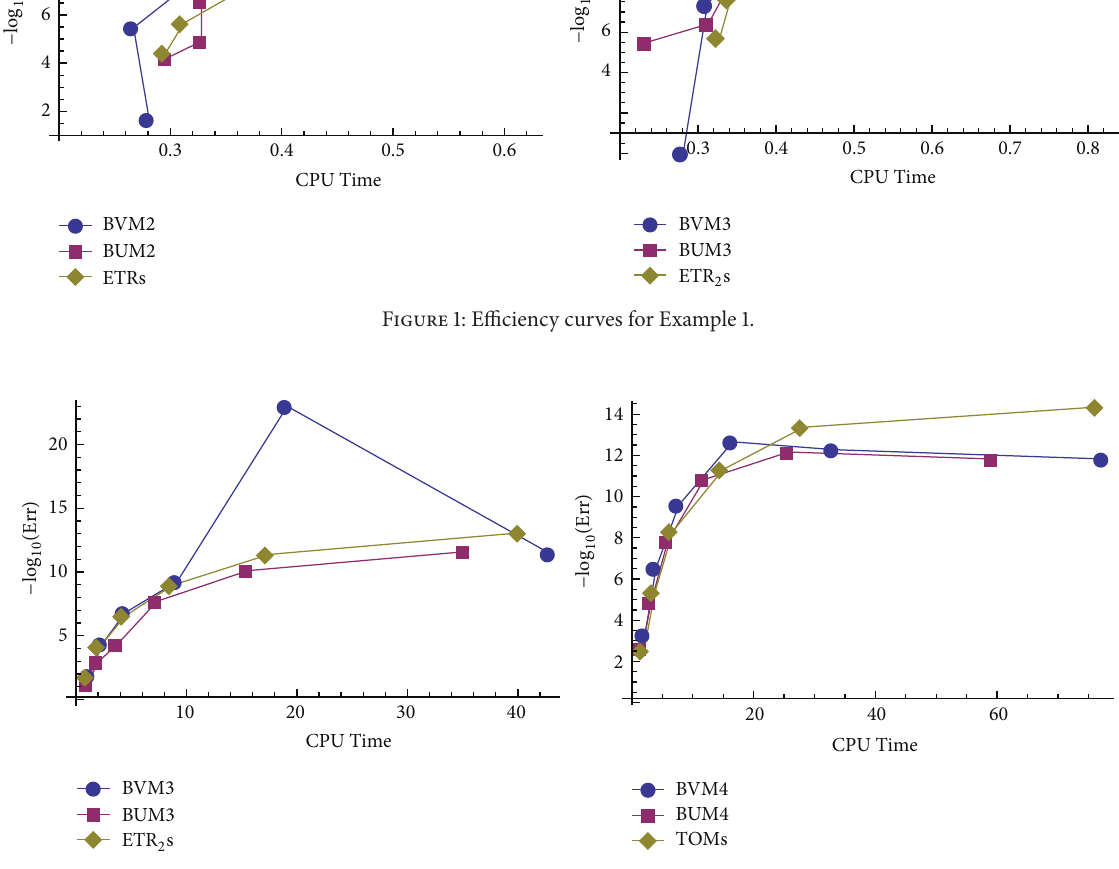
Figure 2: Efficiency curves for Example 2.